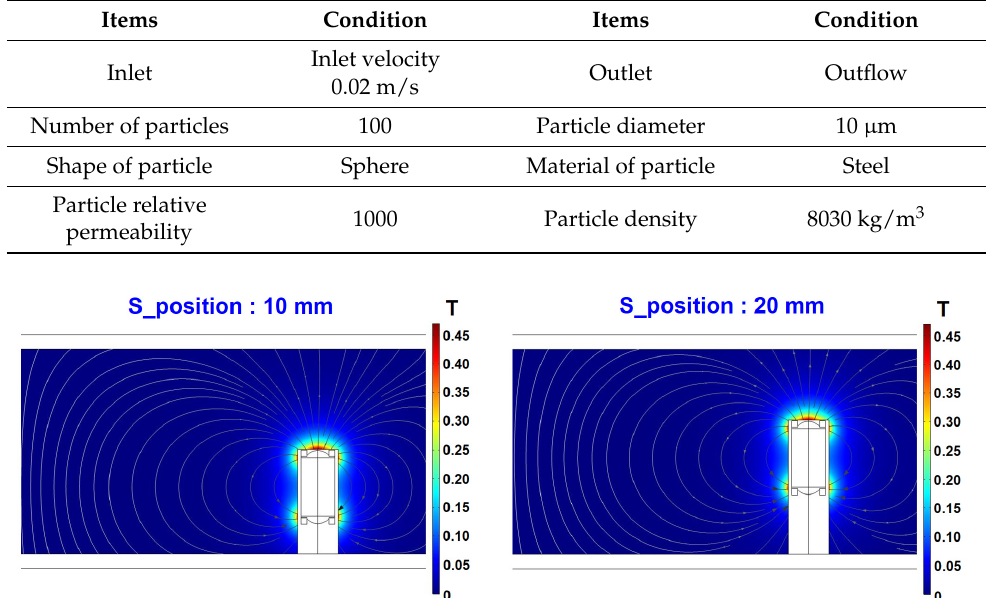
Table 4. Working conditions for the numerical calculations.